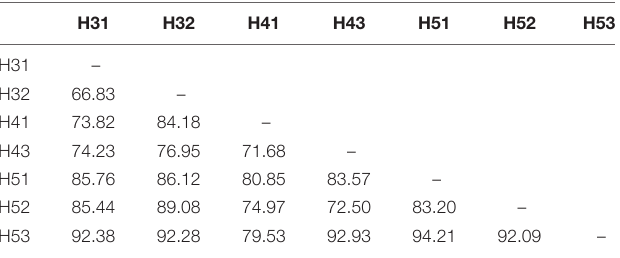
TABLE 4 | Pairwise average dissimilarities between all the samples from the upper and lower aquifers based on Bray–Curtis similarity matrix.